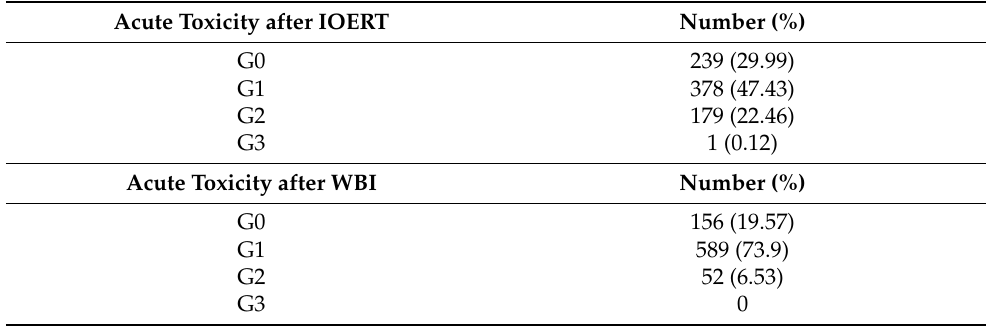
Table 4. Acute toxicity after Intra-Operative Electron Radiation Therapy (IOERT) and after Whole Breast Irradiation (WBI) according to Common Terminology Criteria for Adverse Events (CTCAE) version 4.03.